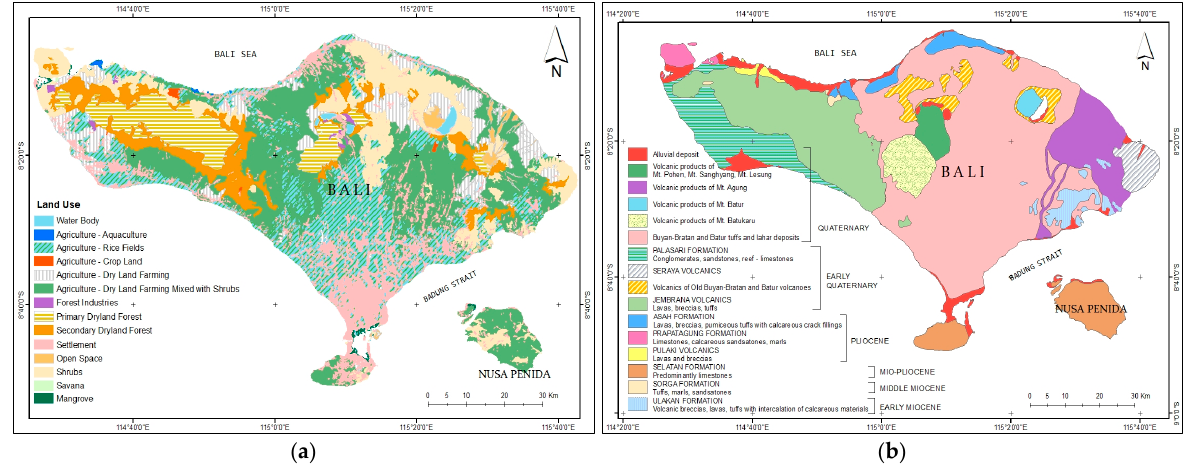
Figure 3. ( a ) Land use map of Bali Province; ( b ) geological map of Bali Province. Geology, in other words, rock-type variables, is a parameter expressing the relative